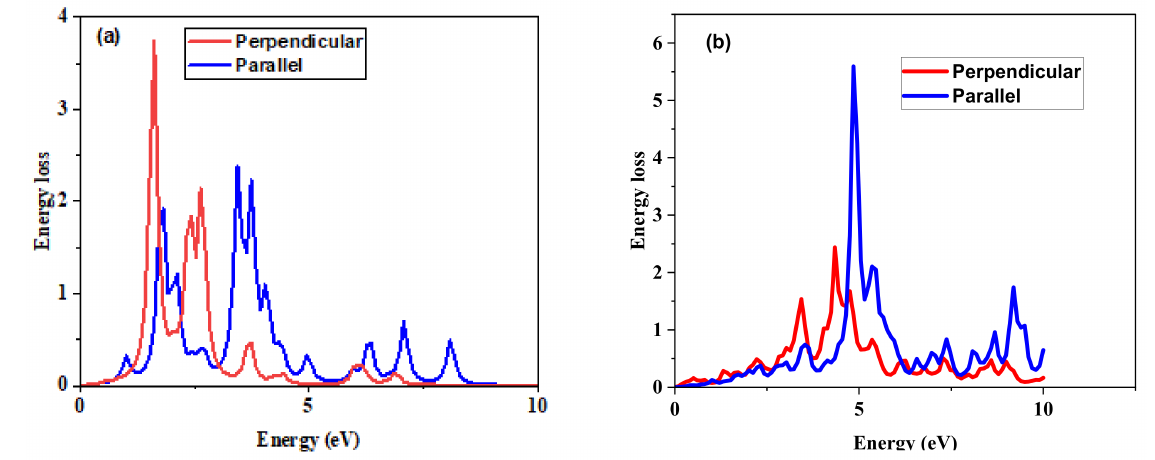
Figure 4. Electron energy loss variations of ( a ) armchair (5, 5) SWBNNT and ( b ) armchair (5, 5) SWCNT structures.